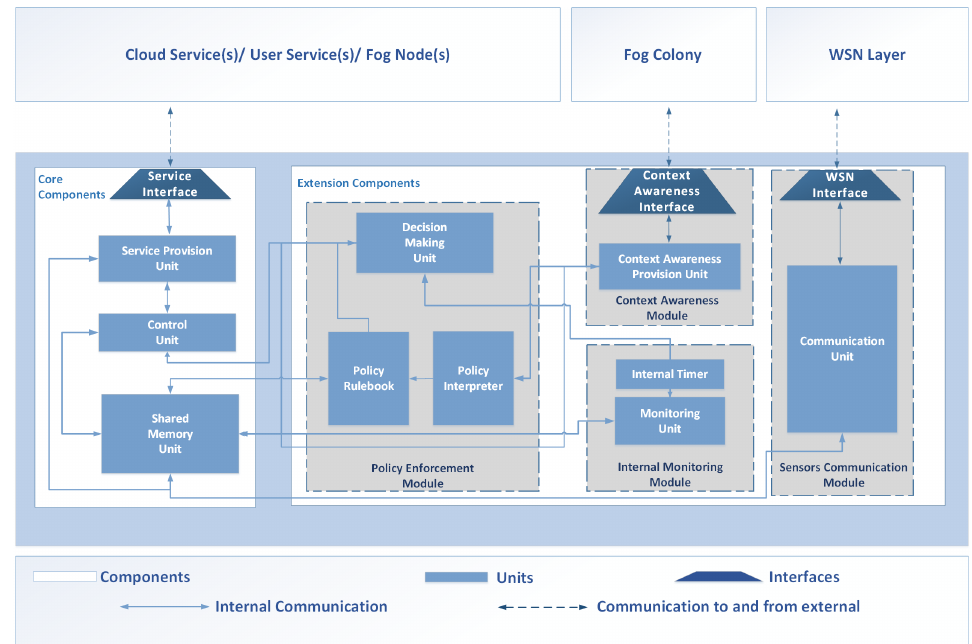
Figure 2. Internal Component Architecture of the Context Aware Autonomous Fog